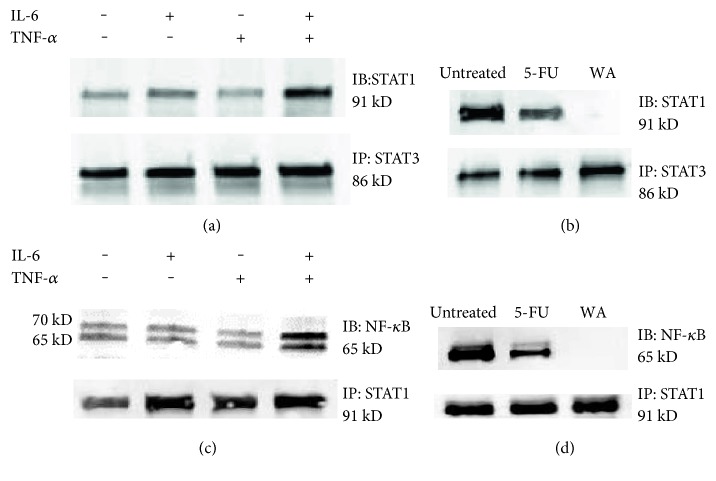
STAT3 dimerize with STAT1 and STAT1 dimerize with NF-κB. Withaferin A abolished the protein-protein interactions. (a) STAT1 was heterodimerized with STAT3 from the pull-down assay with an STAT3 antibody. The binding affinity was increased upon IL-6 and TNF-α cotreatments. (b) Withaferin A (10 μM) treatment has abolished the STAT3-STAT1 interactions. (c) Coimmunoprecipitation with STAT1 antibody revealed that STAT1 was bound to NF-κB. STAT1-NF-κB interaction was enhanced by the IL-6 and TNF-α stimulation. (d) These interactions were also abolished by withaferin A (10 μM) treatment.